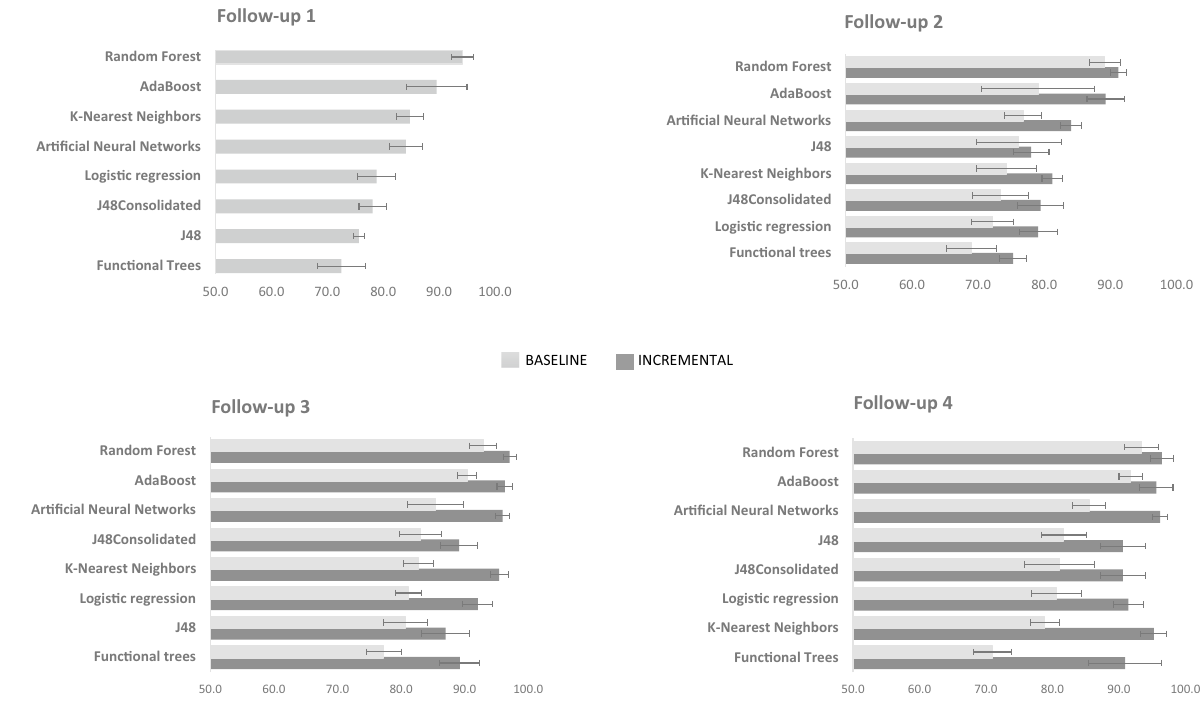
Figure 1. Area Under the Curve-Precision Recall (AUC-PR) for follow-ups 1, 2, 3 and